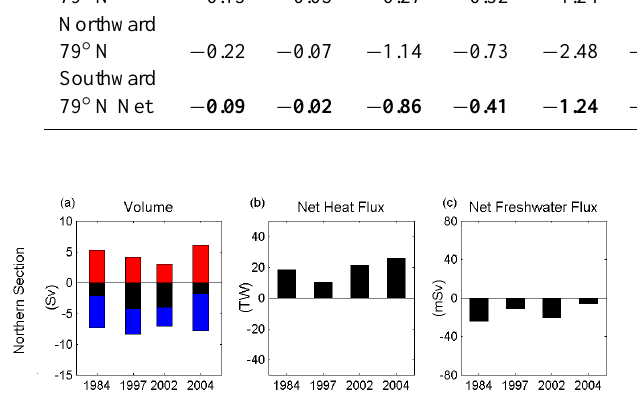
Fig. 8a, b). The correlation between the ADCP mean veloc-